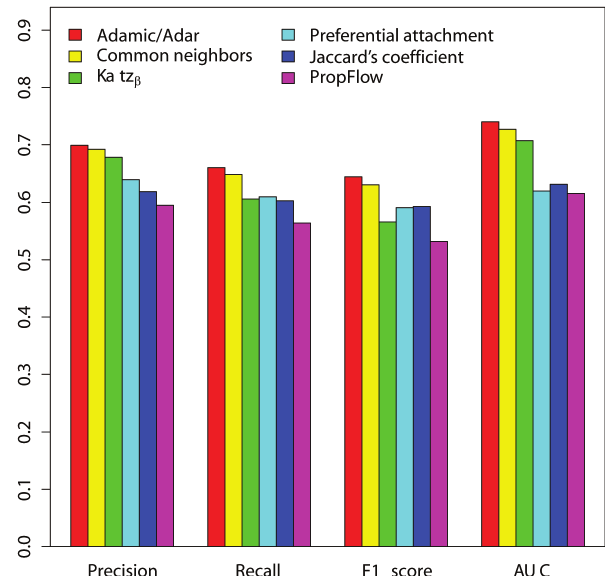
Figure 3. Test results of the LR model for each topological